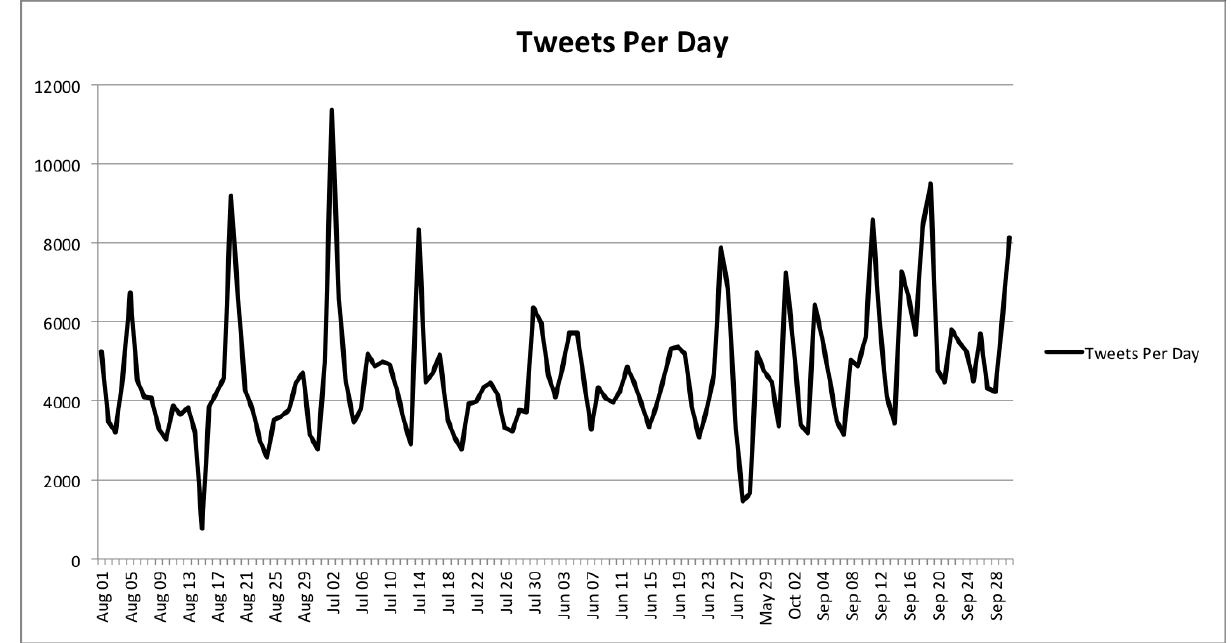
Figure 3. Number of antibiotic-related tweets collected per